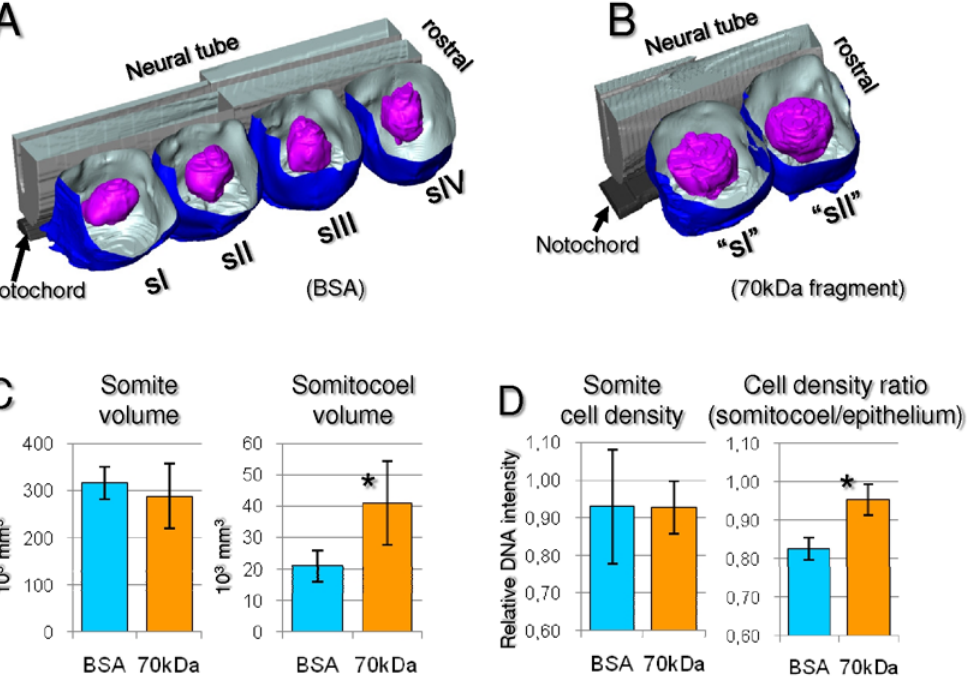
Figure 5. Inhibition of FN fibrillogenesis impairs egression of cells from the somitocoel to the somite epithelium. A–B ) Representative examples of 3D surface reconstructions of somites (blue; dorsal cap digitally removed) and their somitocoels (purple) formed in embryo explants at the end of 6 hours of culture with BSA (n=4; A) or with 70 kDa fragment (n=6; B). Three of the six explants treated with the fragment formed two somites as depicted in B; the remaining ones formed only one somite. C ) Quantification of somite and somitocoel volumes and cell densities (fluorescence intensity of DNA labeling). Only somites fully separated from the PSM ( $ sI) were measured. Since an ANOVA revealed no significant differences between somites formed during the 6 hour culture period within each treatment, we pooled the measurements of the different somites to an average per explant (C). There is no significant difference ( P =0.129) in somite volume between control and fragment-treated explants, but somitocoels of fragment-treated explants are significantly larger ( P , 0.0001). D ) Quantification of cell density in the whole somites shows no difference ( P =0.990) between control and 70 kDa fragment-treated explants. However, the cell density ratio (somitocoel/epithelial portion) is significantly higher ( P =0.043) in somites of 70 kDa fragment-treated explants. Bars represent 95% confidence